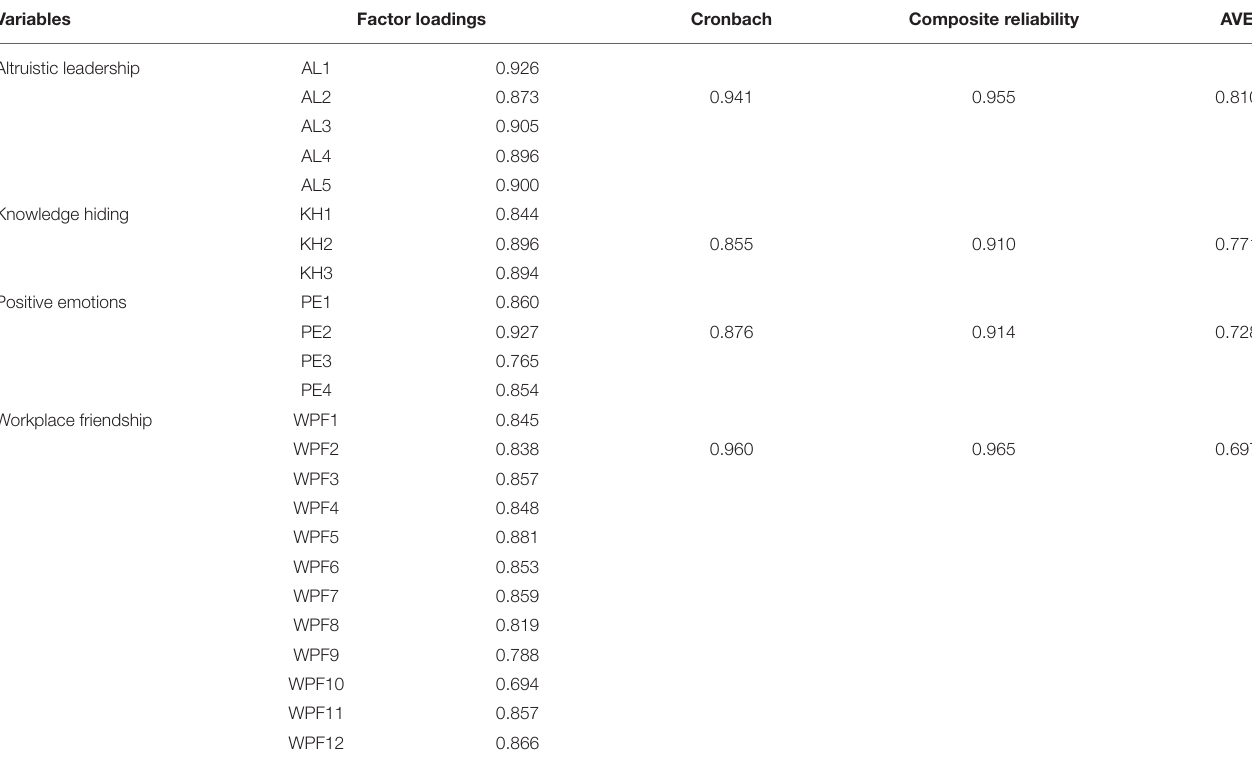
TABLE 2 | Factor loadings cronbach alpha, composite reliability, and